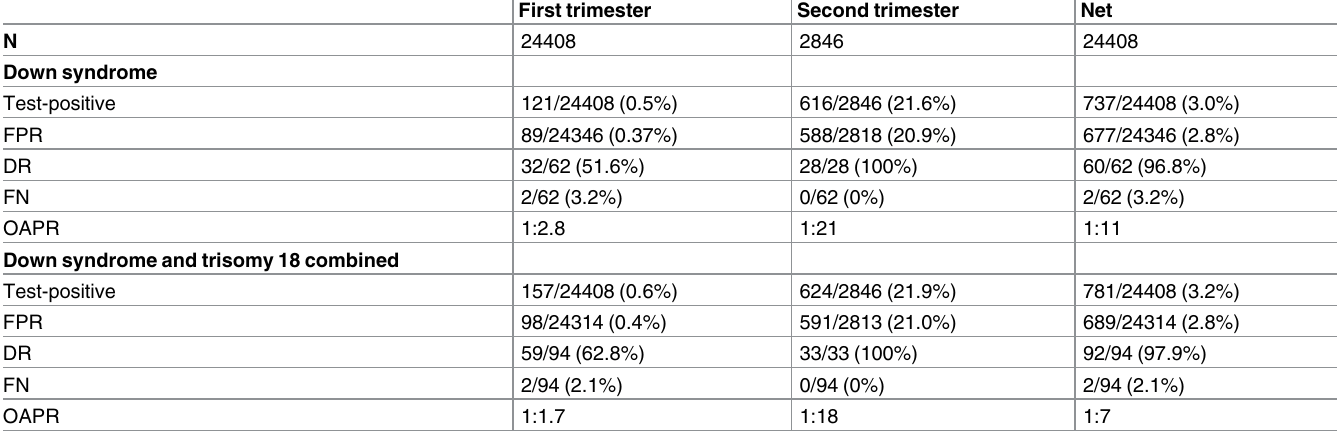
Table 1. Overall, first and second trimester results of contingent screening for Down syndrome alone and for Down syndrome and trisomy 18